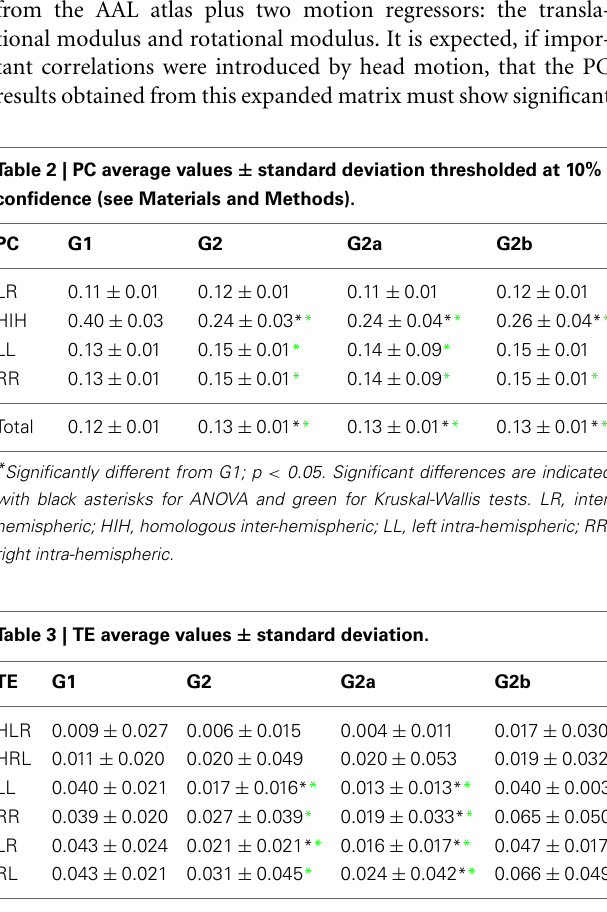
with black asterisks for ANOVA and green for Kruskal-Wallis tests. HLR: homolo- gous inter-hemispheric from left to right; HRL, homologous inter-hemispheric from right to left; LL, left intra-hemispheric; RR, right intra-hemispheric; LR, inter-hemispheric left to right; RL, inter-hemispheric right to